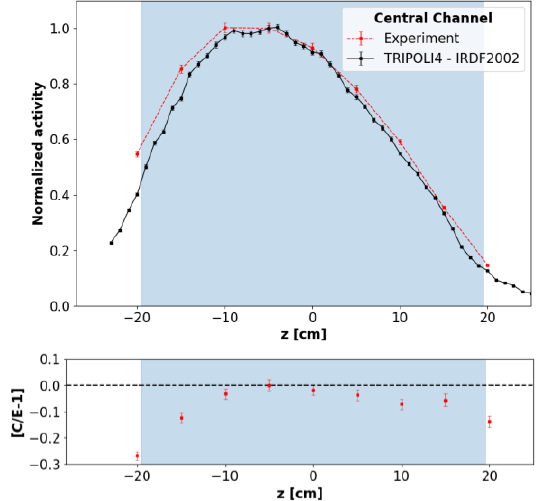
Fig. 10. Measured and calculated axial profile of 58 Ni(n, p) 58 Co reaction rates in the reactor core central channel normalized to the maximal value. Fig. 11 shows a good agreement between the measured and calculated normalized gold reaction rates in 8 positions among the 40 in the rotary groove facility. The relative differences between the calculated and experimental values are in average around 6% (1σ). However, the 1σ statistical uncertainty in the calculated reaction rates have varied between 1% to 5% (in